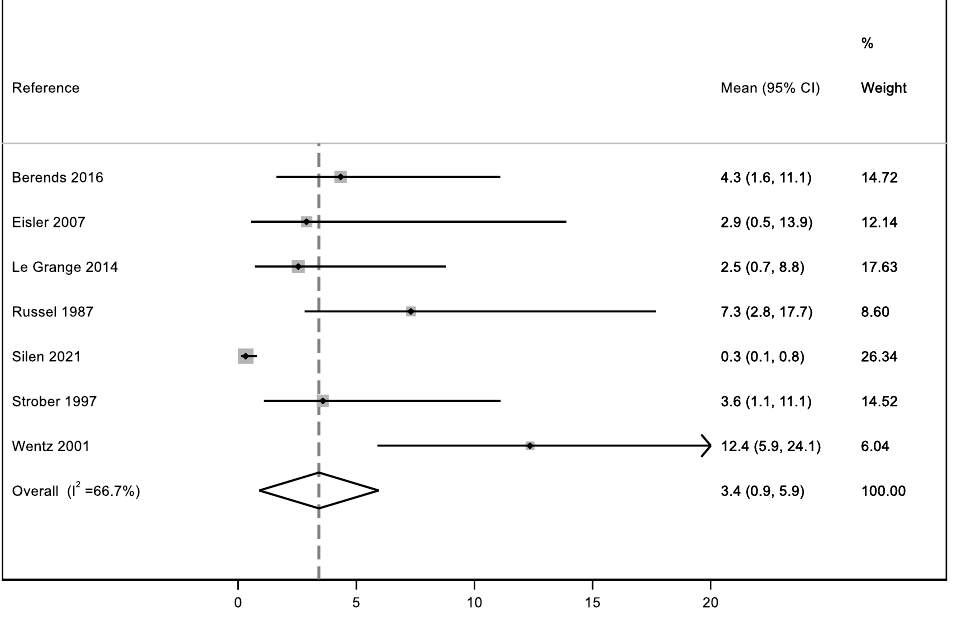
Figure 4. Meta-analysis of ED mean duration from its onset to early adulthood [31,40,66,72,74,76].